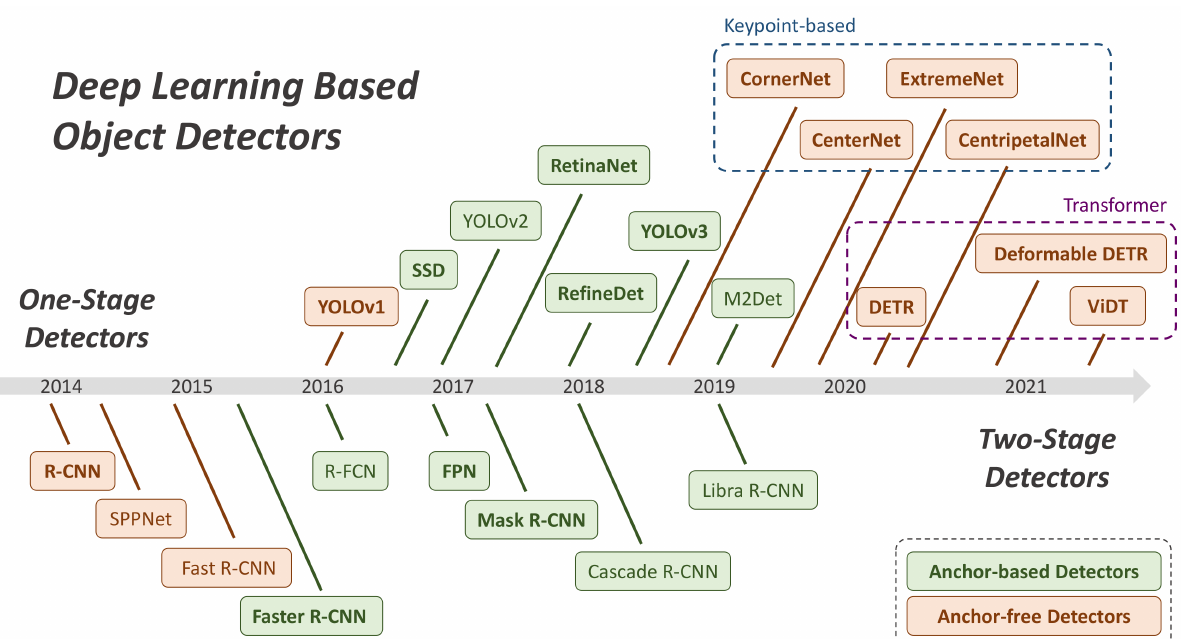
Figure 6. A road map of deep learning object detection. The models above the timeline are one-stage detectors, and the models below the timeline are two-stage detectors. The models in green are anchor- free ones while the models in orange are anchor-based ones. The models in the bond are